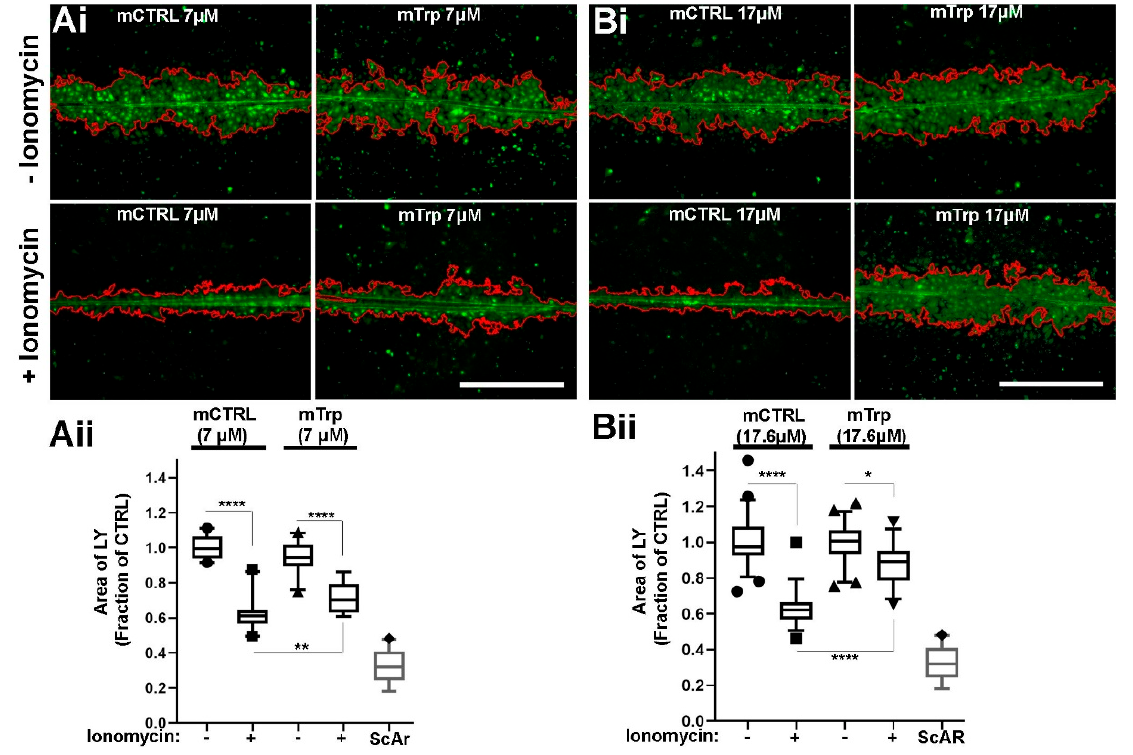
Figure 10. mTrp peptide reverses Ca 2+ -dependent GJ uncoupling in HUVEC. Ai-Bi, representative images showing LY spread 8 min after lesion formation following an 8-min pre-exposure to 7 μ M ( Ai ); or 17 μ M ( Bi ) mCtrl; or mTrp peptide with (bottom panels); or without (top panels) ionomycin, as indicated. Red lines in images show the area of LY spread. ( Aii , Bii ) quantification of LY spread normalised to control peptide minus ionomycin for data in ( Ai , Bi ). The data are pooled from two independent experiments. Each experiment was analysed by ANOVA in GraphPad Prism. **** p < 0.0001, ** p = 0.0073, * p = 0.041. Data are expressed as for Figure 7. The area of the scratch lesion (ScAr) is also indicated ( n = 29). Scale bar 500 μ m.